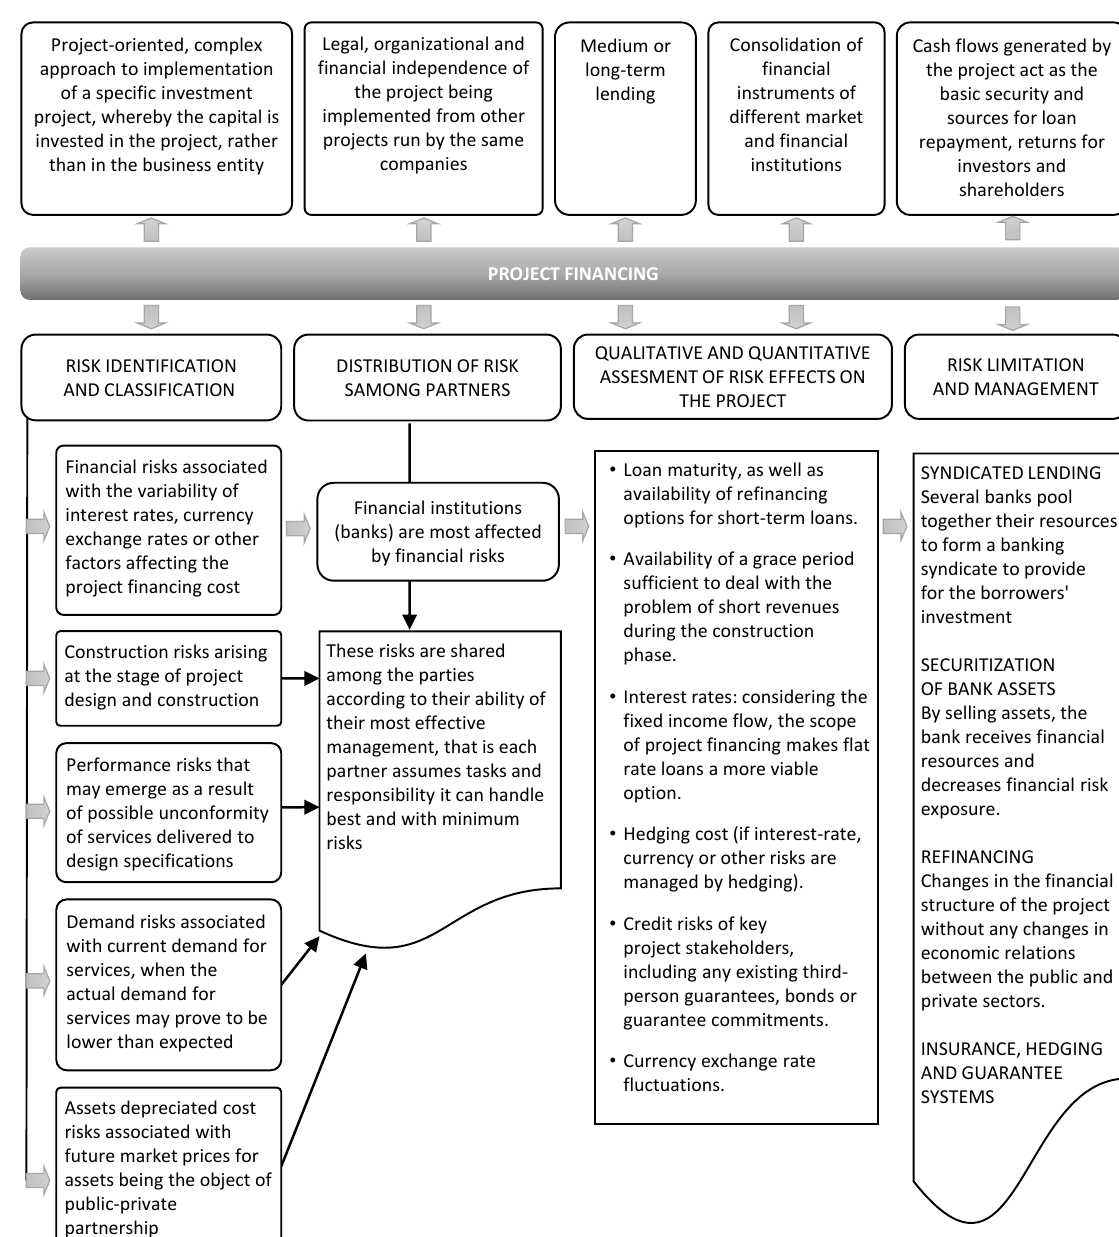
Financial institutions (banks) are most affected by